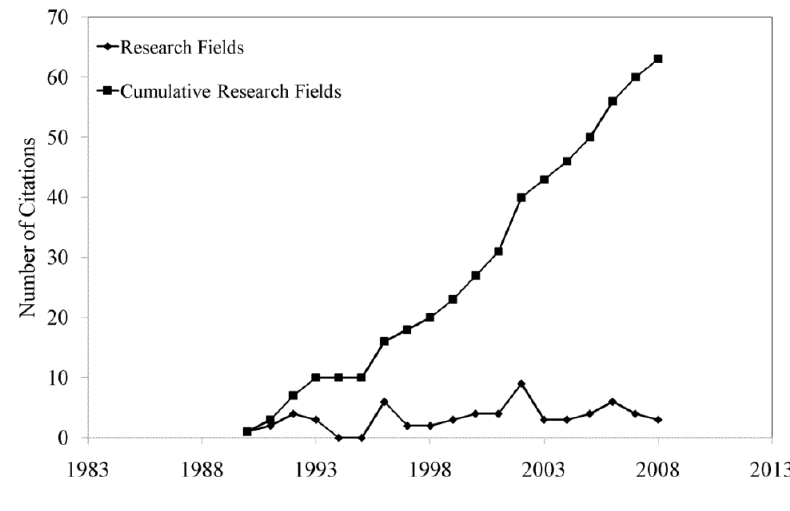
Figure 5. “Citations of the reverse salient concept in research